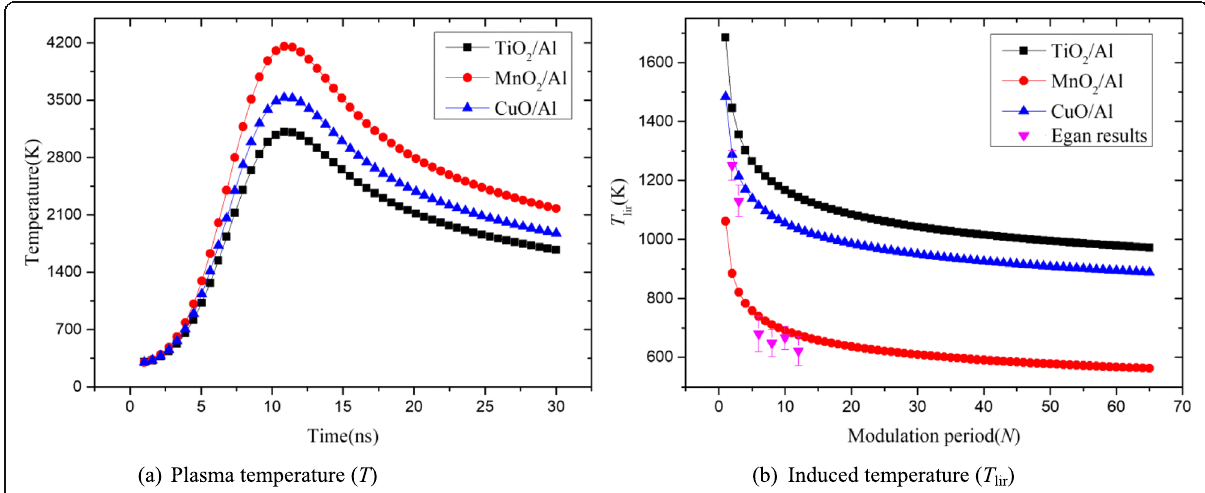
Fig. 10 Relationship of modeled a laser-induced plasma temperature ( T ) over times and b induced temperature ( T lir ) with number of modulation periods of the